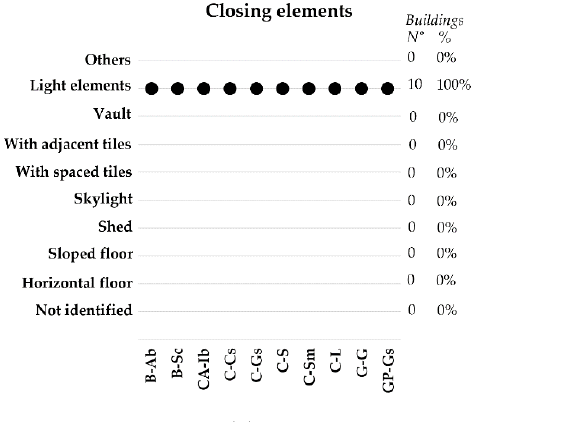
Figure 15. Section 1B CARTIS-Building. ( a ) Closing elements; ( b ) Foundation.